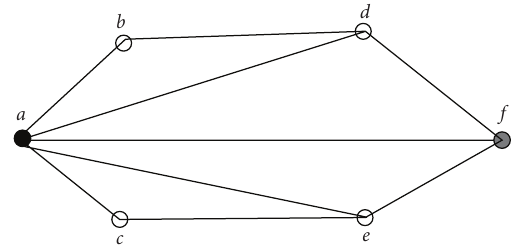
Figure 6: Non-Delaunay triangles (cid:2) abd , (cid:2) adf , (cid:2) ace , and (cid:2) ae f are created in